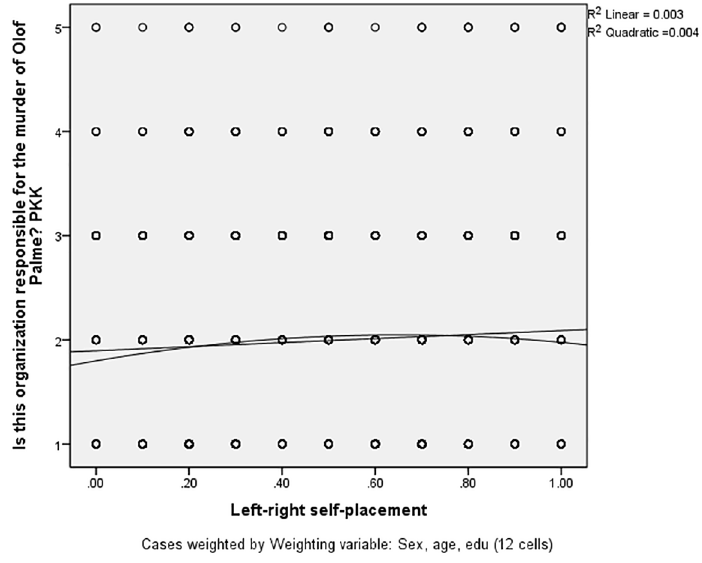
Figure 7. Linear and quadratic relationship between political ideology and belief that PKK was responsible for the murder of Olof